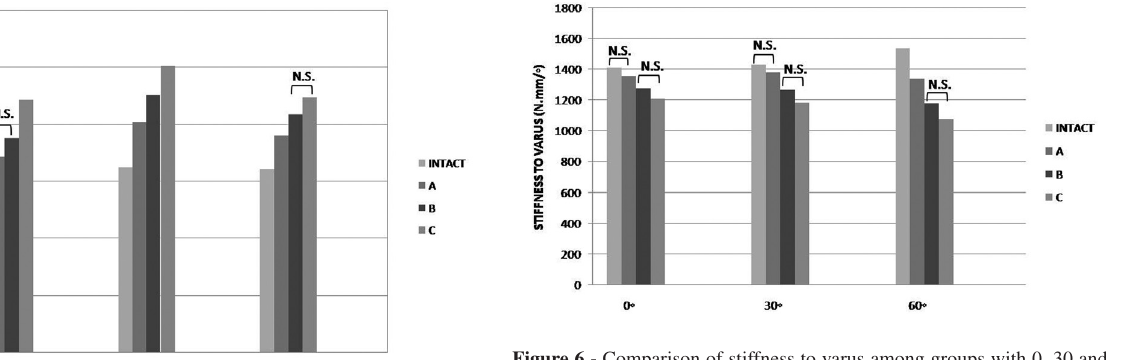
6 - Comparison of stiffness to varus among groups with 0, 30 and 60 degrees of flexion. All values were significant, except where notated N.S. (not significant).